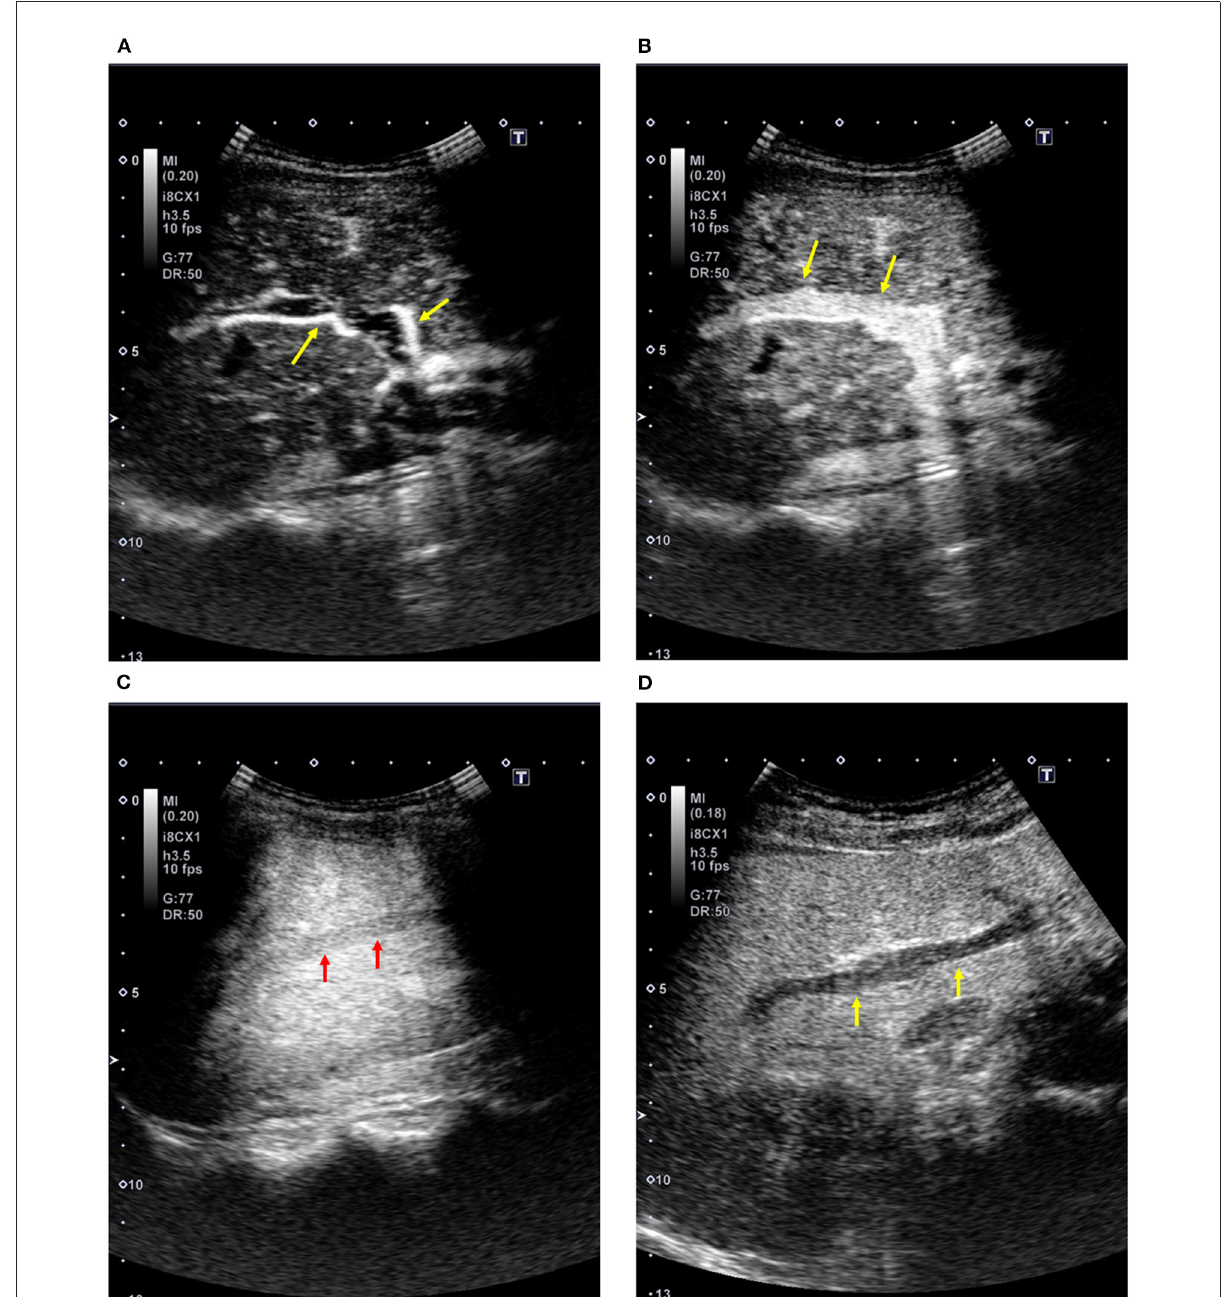
FIGURE1 Contrast-enhanced ultrasound of the liver (Sonazoid; healthy subject, 51-year-old women). (A) Arterial phase: The sonogram shows an enhancement in the right hepatic artery (arrows). (B) Portal venous phase: The sonogram shows an enhancement in the right portal vein (arrows). (C) Contrast enhancement in the hepatic vein: The sonogram shows an enhancement in the right hepatic vein (arrows). (D) Post-vascular phase (12min after the injection): The sonogram shows homogeneous enhancement in the liver parenchyma with the absence of enhancement in the intrahepatic vessels